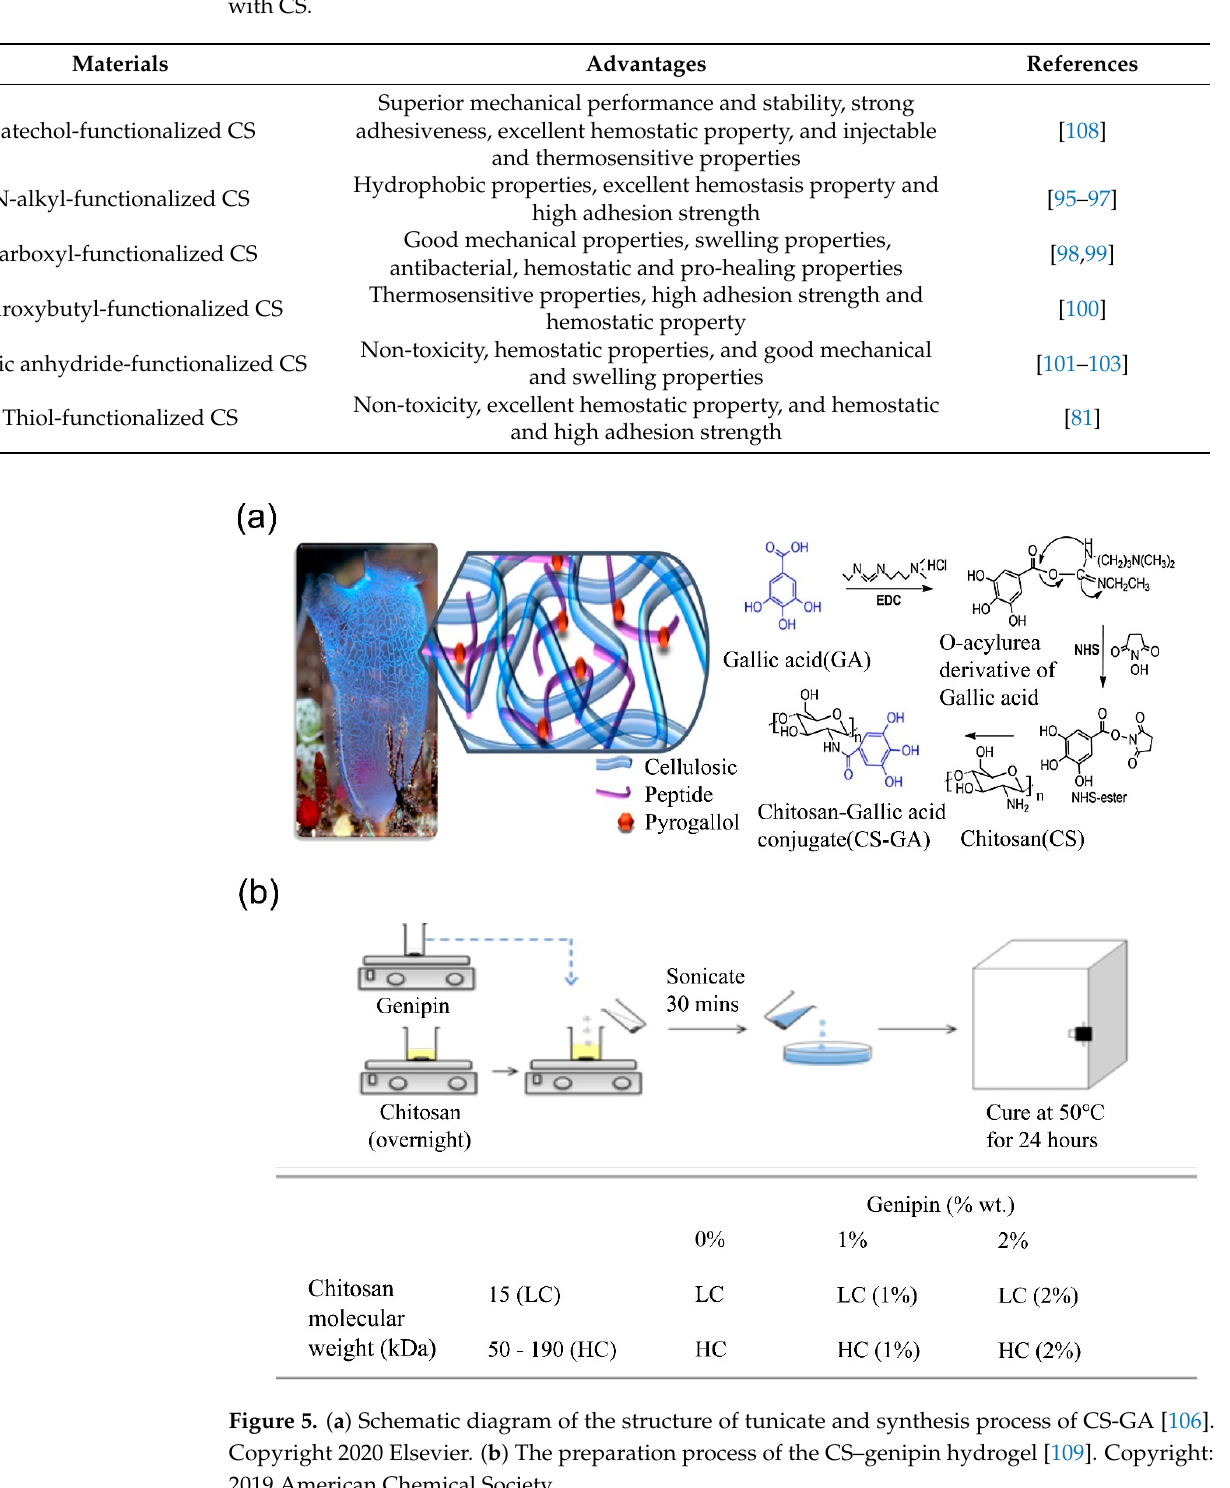
Table 2. Construction of hemostatic hydrogels and their properties by combining different materials with CS.